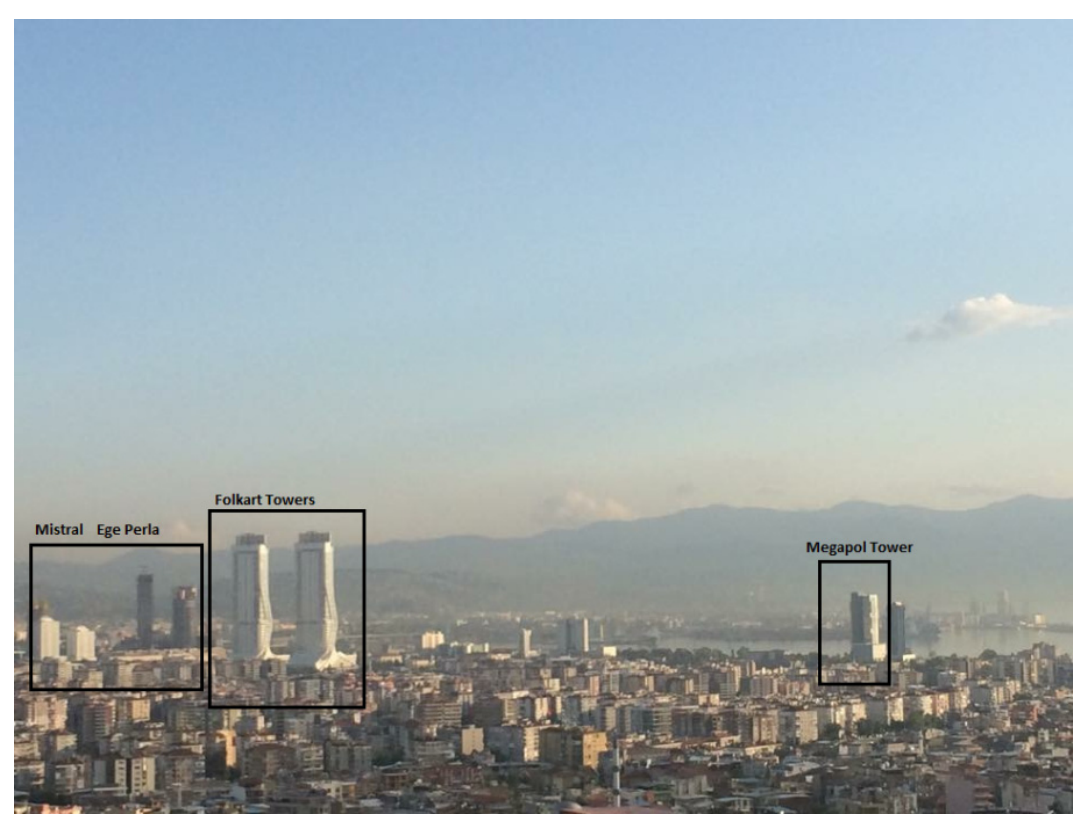
Figure 8. External View of Folkart Towers with other buildings. Photograph by Asli Ceylan